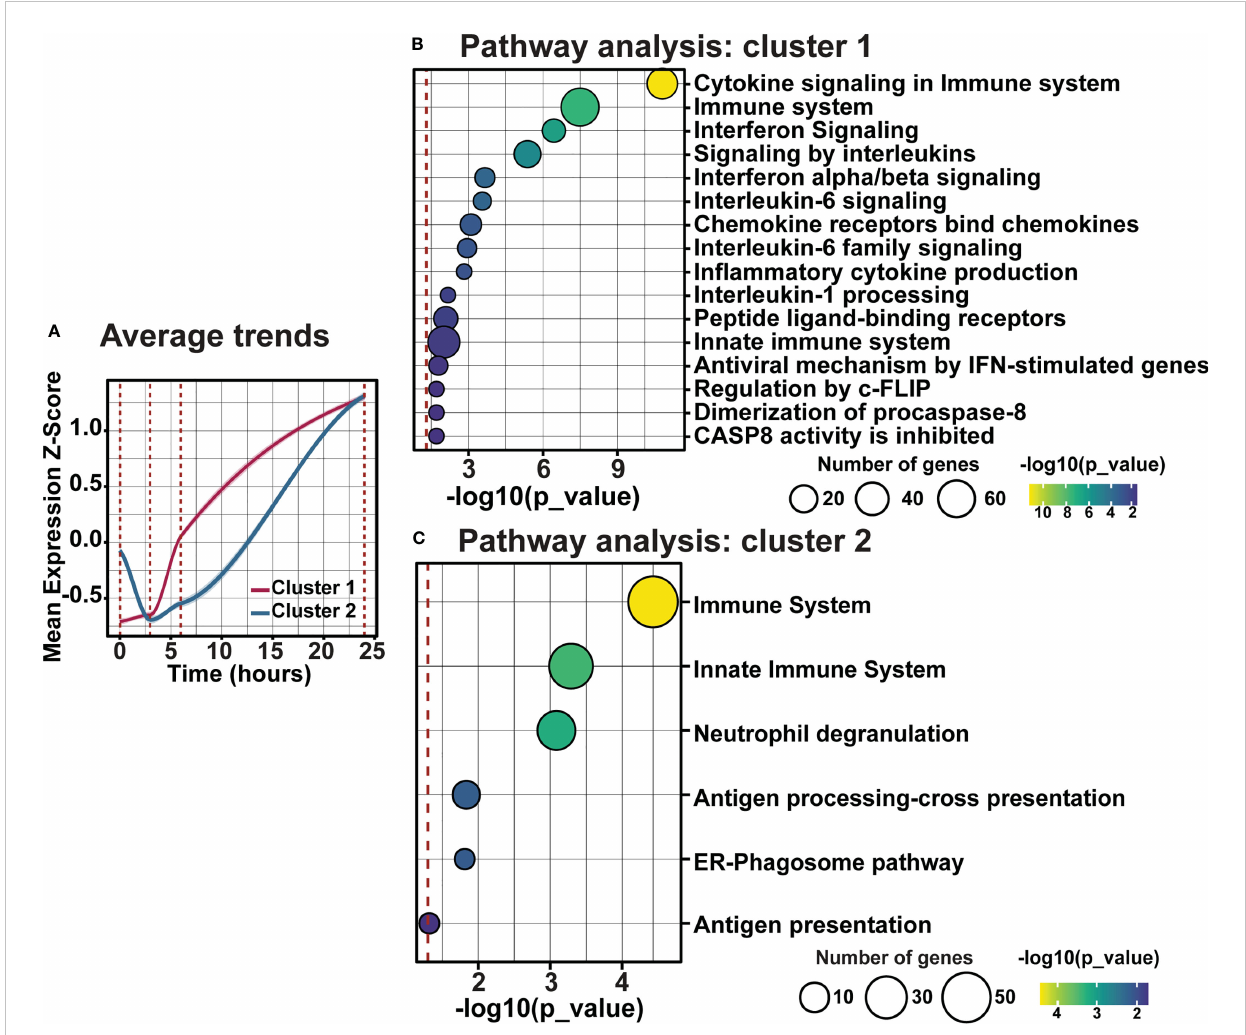
(Figure 10Aiv; black arrow). In comparison, strong miR-124-3p labelling was present in the outer limiting membrane (OLM) in DR controls, with weaker labelling in the ONL and INL, however by 3h- PD labelling in the OLM appeared to decrease while INL labelling was stronger in appearance (Figures 10Bi-iv). In support of predicted target locations, both miR-155-5p and miR-124-3p were found to be expressed in photoreceptors and cells of the inner retina. Levels of miRNA were further quanti fi ed by qRT-PCR across the early and late photo-oxidative damage with miR-155-5p expression found to signi fi cantly increase in expression between 12h-PD to 5d-PD compared to DR controls (Figure 10C, p < 0.05). No change was found in the expression of miR-124-3p across any time point (Figure 10D, p > 0.05 ). Finally, to determine the overall potential strength of miR-124-3p and miR-155-5p interactions across photo-oxidative damage, miRNA target enrichment